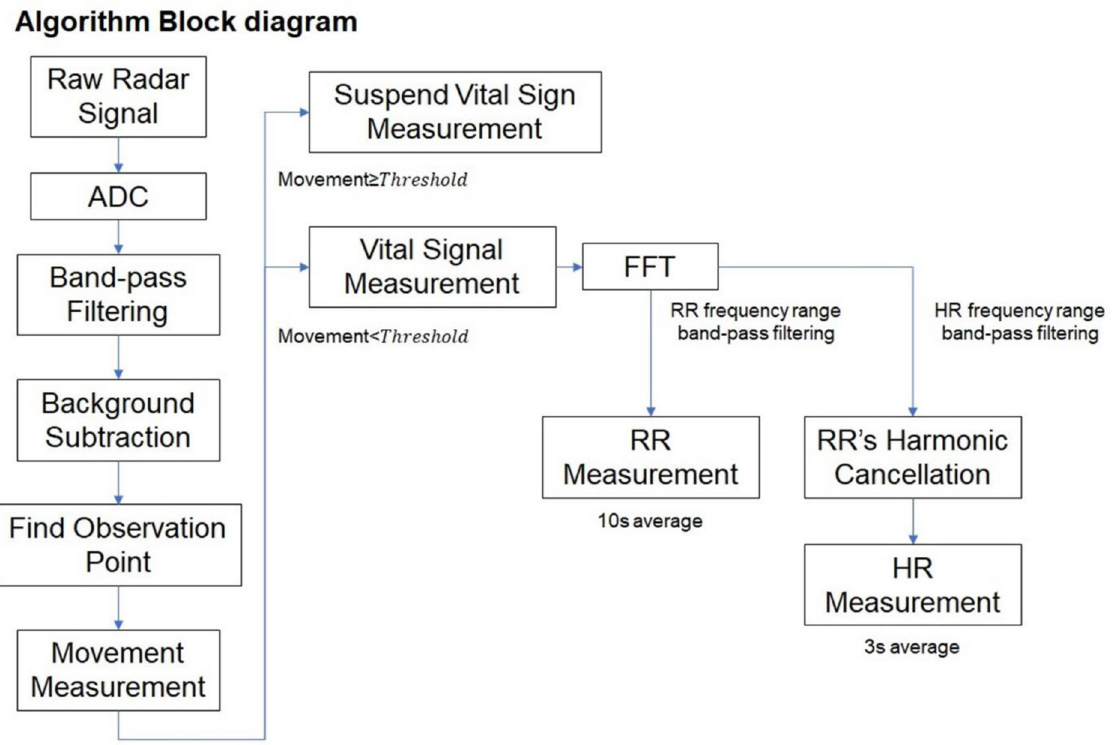
Fig 3. Algorithm block diagram. HR and RR detection algorithm for neonates redesigned from the algorithm used for adults. Because the raw signals received from the radar contained noise components, signal processing algorithms were applied to the raw signal. After the breathing waveform and its harmonics were removed using a band-pass filter, the HR frequency components were estimated using fast Fourier transform.